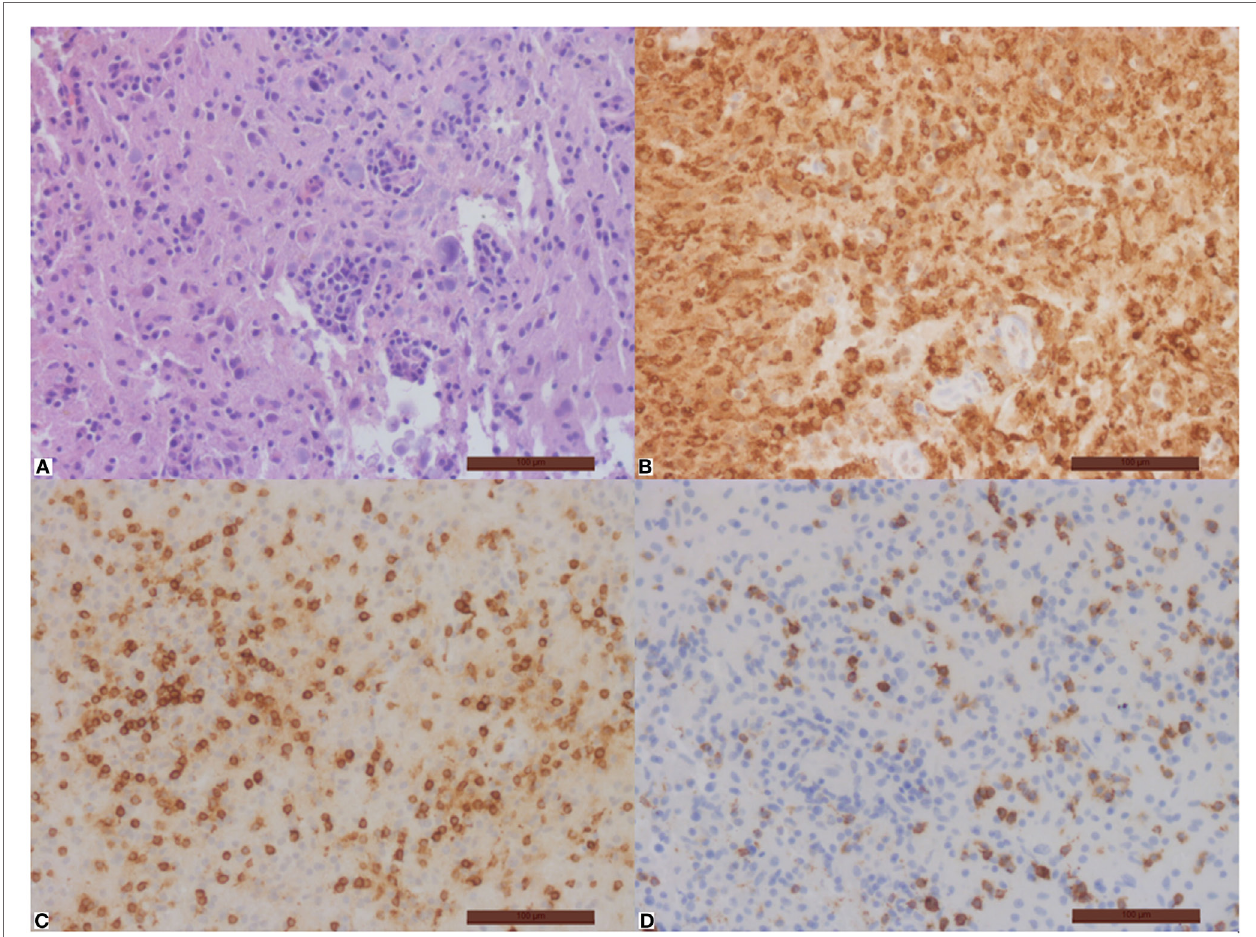
FIgURe 3 | Important inflammation of the brain tissue with disseminated macrophages (B) and T-cells (C) , no B-cells. Part of the T-cells is CD8-positive (D) . Hematoxylin–eosin (a) , immunohistochemical stain with antibodies against CD68 (B) , CD3 (C) , and CD8 (D) . Magnification bar = 100